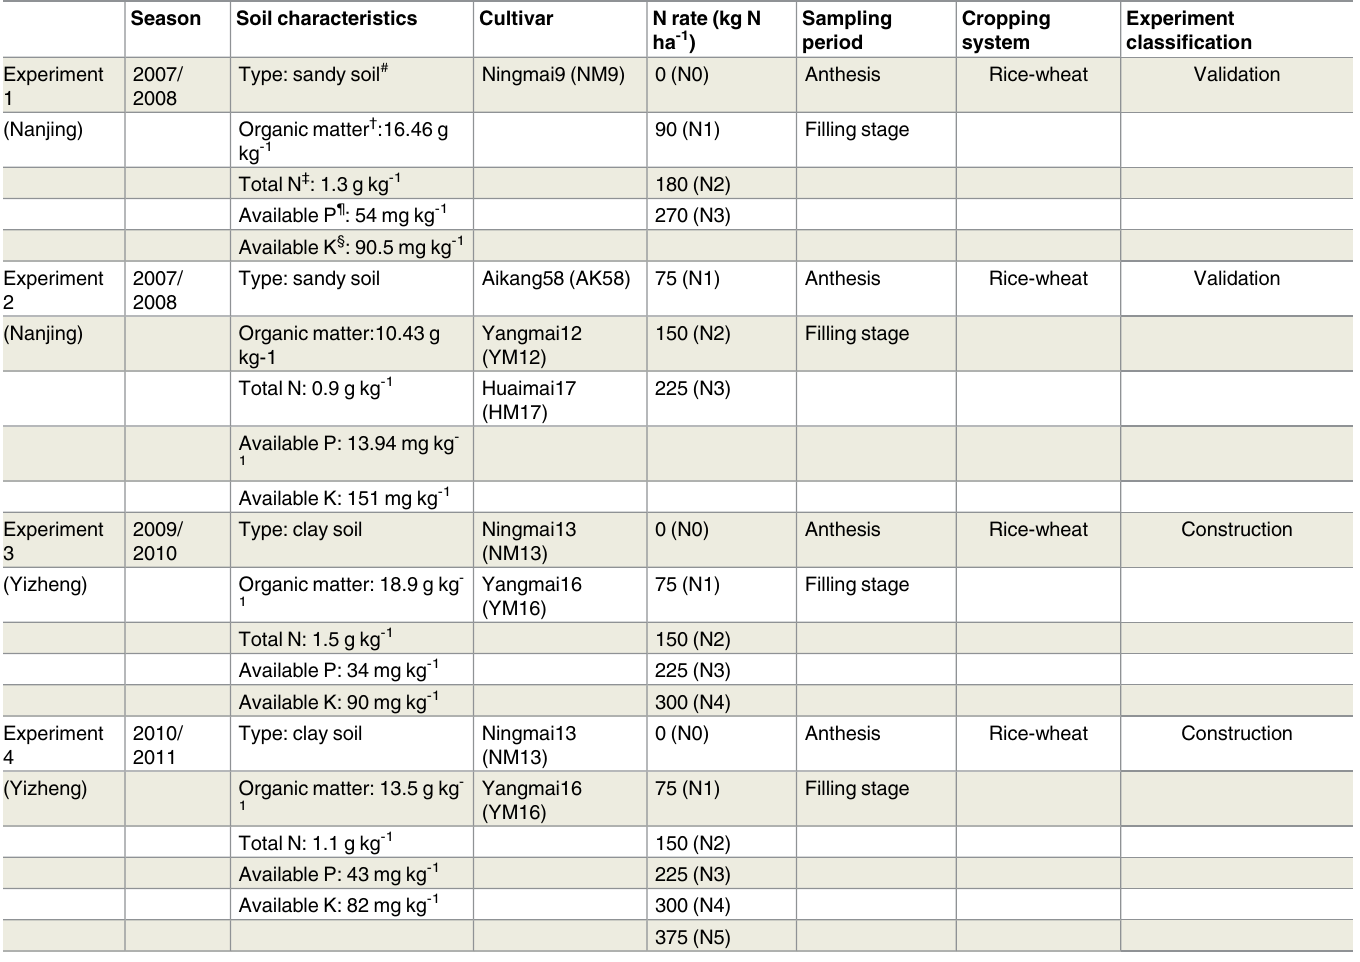
Table 1. The basic information about the four experiments conducted in present study.